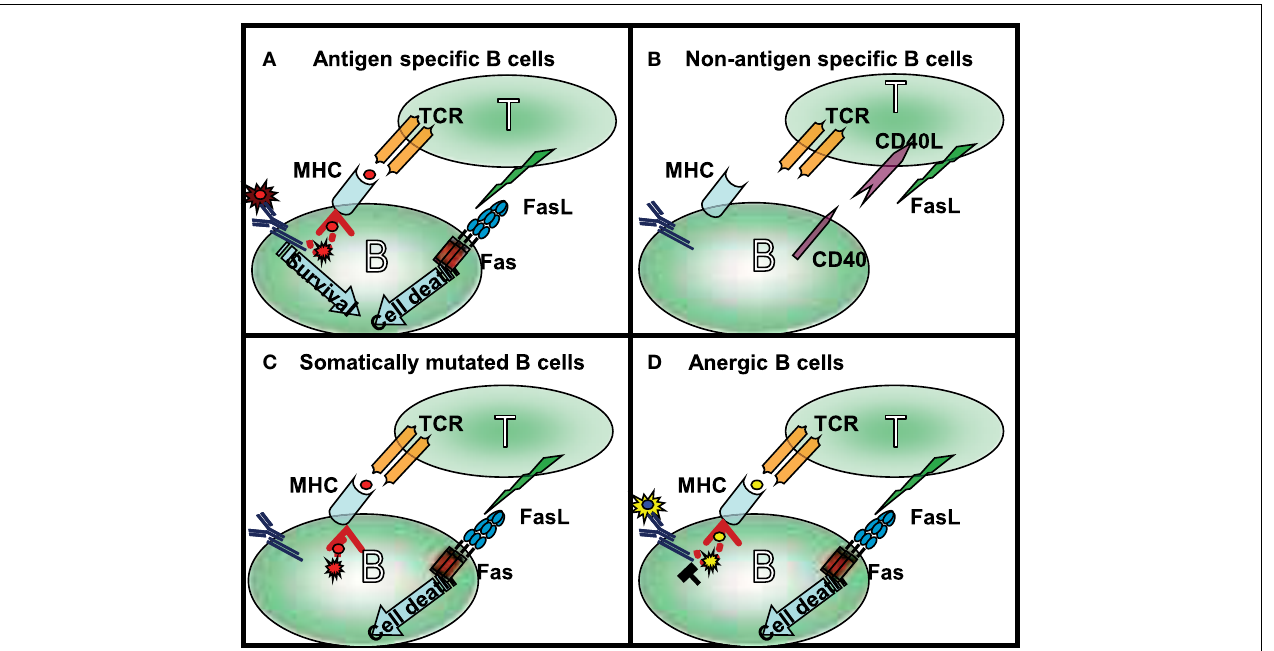
cells are not targets of Fas-induced cell death. (C) The low affinity B cells, and B cells which lost antigen-specificity because of somatic mutation, are first targets of Fas-mediated killing. Maintaining antigen presenting capacity, but losing antigen triggering in the competition for the antigen, these cells contact theT cells, but do not access the survival signal.This explains the elevated antibody level in lpr mice where the antigen non-specific B cells can survive. (D) Anergic B cells are the main targets of Fas-mediated killing; the antigen receptor signaling of anergic B cells is desensitized due to their permanent activation.This group can explain the enhanced autoantibody production observed in lpr mice.